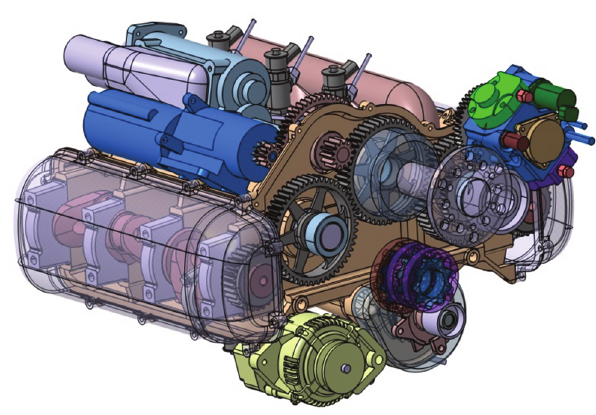
Fig. 1. Visualization of the new construction of the opposed-piston engine Nowadays, material databases count tens of thousands of different materials so selecting an appropriate structural material is a complex task. Product designing is a multi- step process. Most of these steps face open problems where is no only one correct solution but better and worse